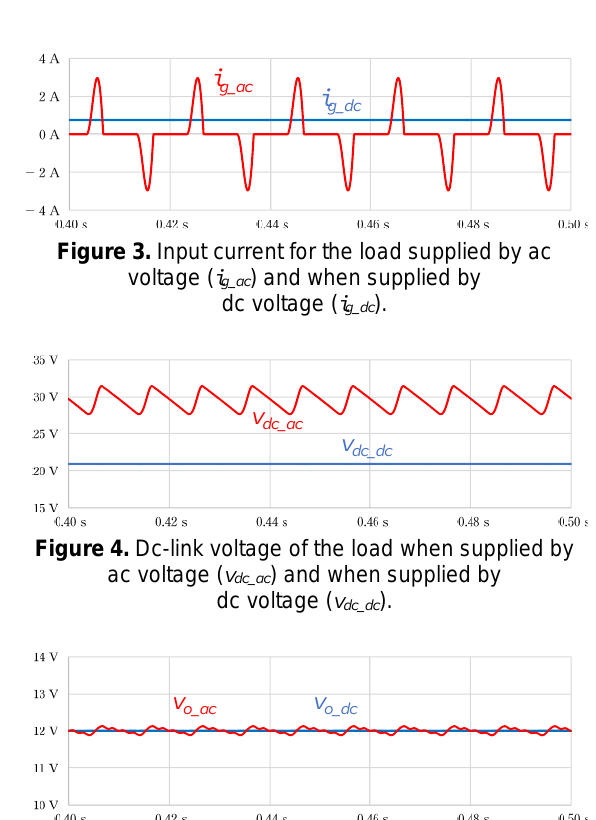
Figure 5. Output voltage of the load when supplied by ac voltage ( v o_ac ) and when supplied by dc voltage ( v o_dc ).